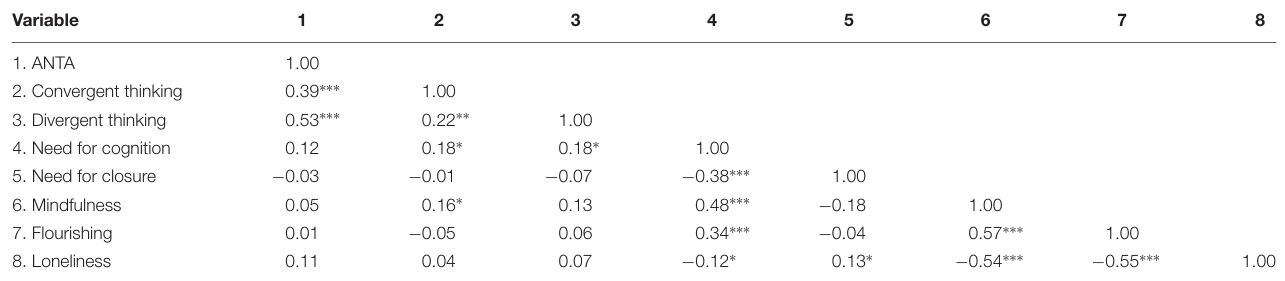
TABLE 6 | Correlation matrix.